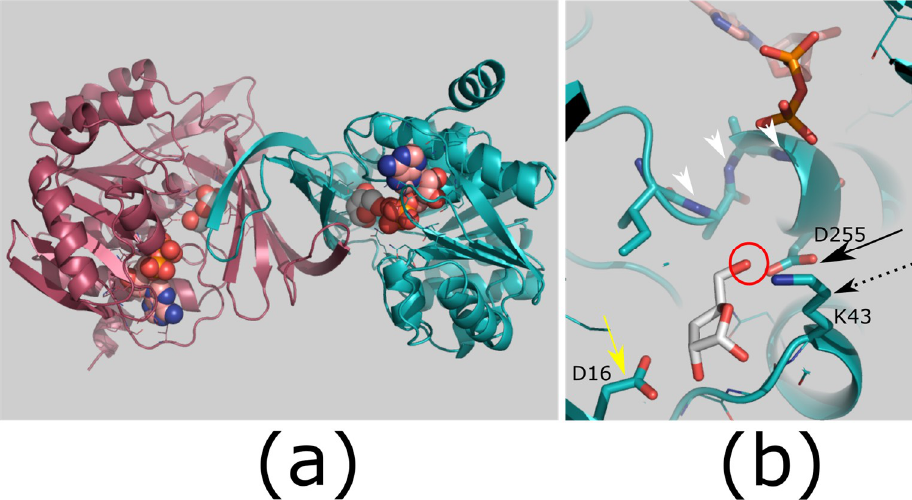
Figure 4. Structure and mechanism of ribokinases. ( a ) Dimerization of ribokinases. The small β -sheet domains of two monomers (raspberry and teal) join to form a β -clasp. ( b ) Proposed mechanism for ribokinases. The reactive hydroxyl (red circle) is deprotonated by an aspartic acid (catalytic base; black arrow; D255). This will attack the γ -phosphate of ATP. The pentacoordinate transition state is stabilized by a lysine side chain (black dashed arrow; K43) and by an anion hole produced by main chain amides (white arrowheads). An additional side chain helps to bind the sugar hydroxyls (yellow arrow; D16). A divalent cation was not observed in this crystal structure but is essential for catalysis. Colors: ligand bound enzyme (teal; PDB ID: 1RKD [18]). Ligands ribose (white carbons; substrate) and ADP (carbons pink; product). Images generated using PyMOL version 1.8.